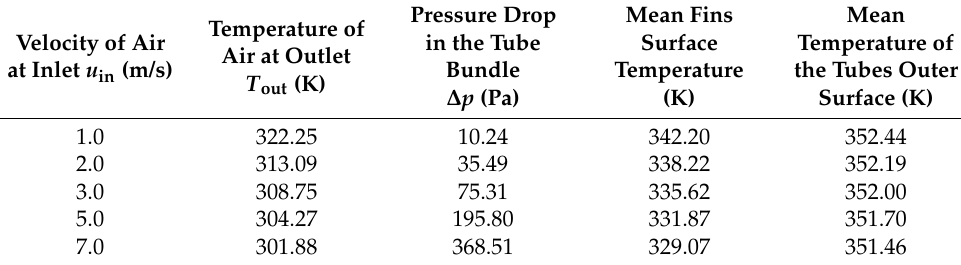
Table 3. Output data for the trimming diameter of 28 mm.